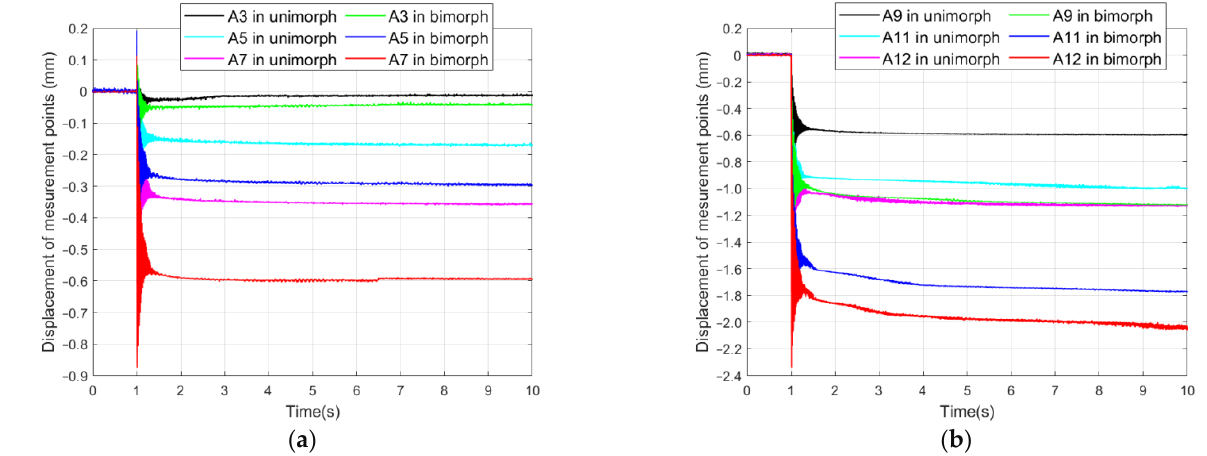
Figure 11. Displacements of measurement points in unimorph and bimorph: ( a ) A3, A5 and A7; ( b ) A9, A11 and A12.